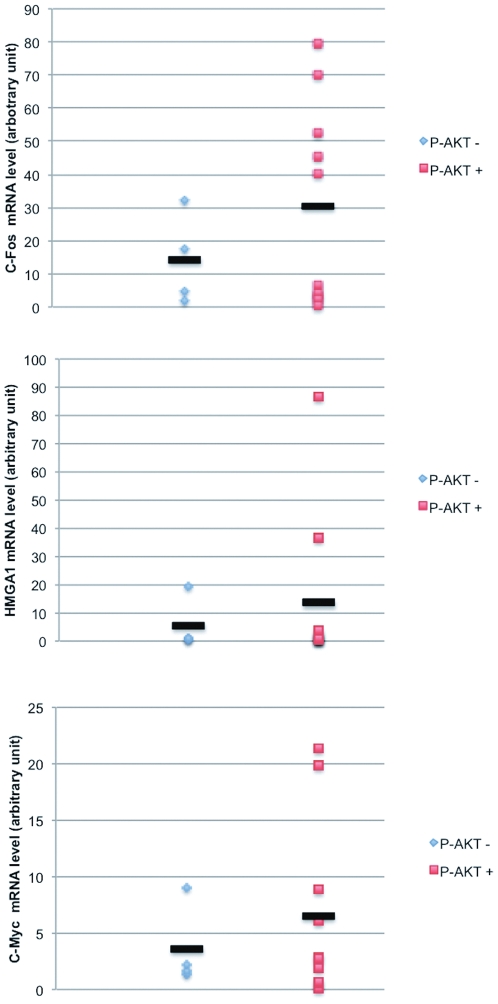
Activation of PI3KCA regulates expression of HMGA1, c-Fos, c-MYC in primary NSCLC.Quantitative real-time RT-PCR analysis of c-Fos, HMGA1, c-Myc gene expression in primary NSCLCs.